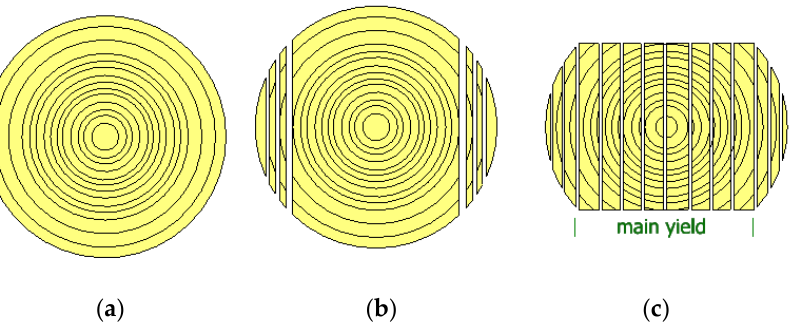
Figure 1. A schematic diagram of timber conversion: ( a )—cant sawing, ( b )—side board sawing, ( c )—main yield.